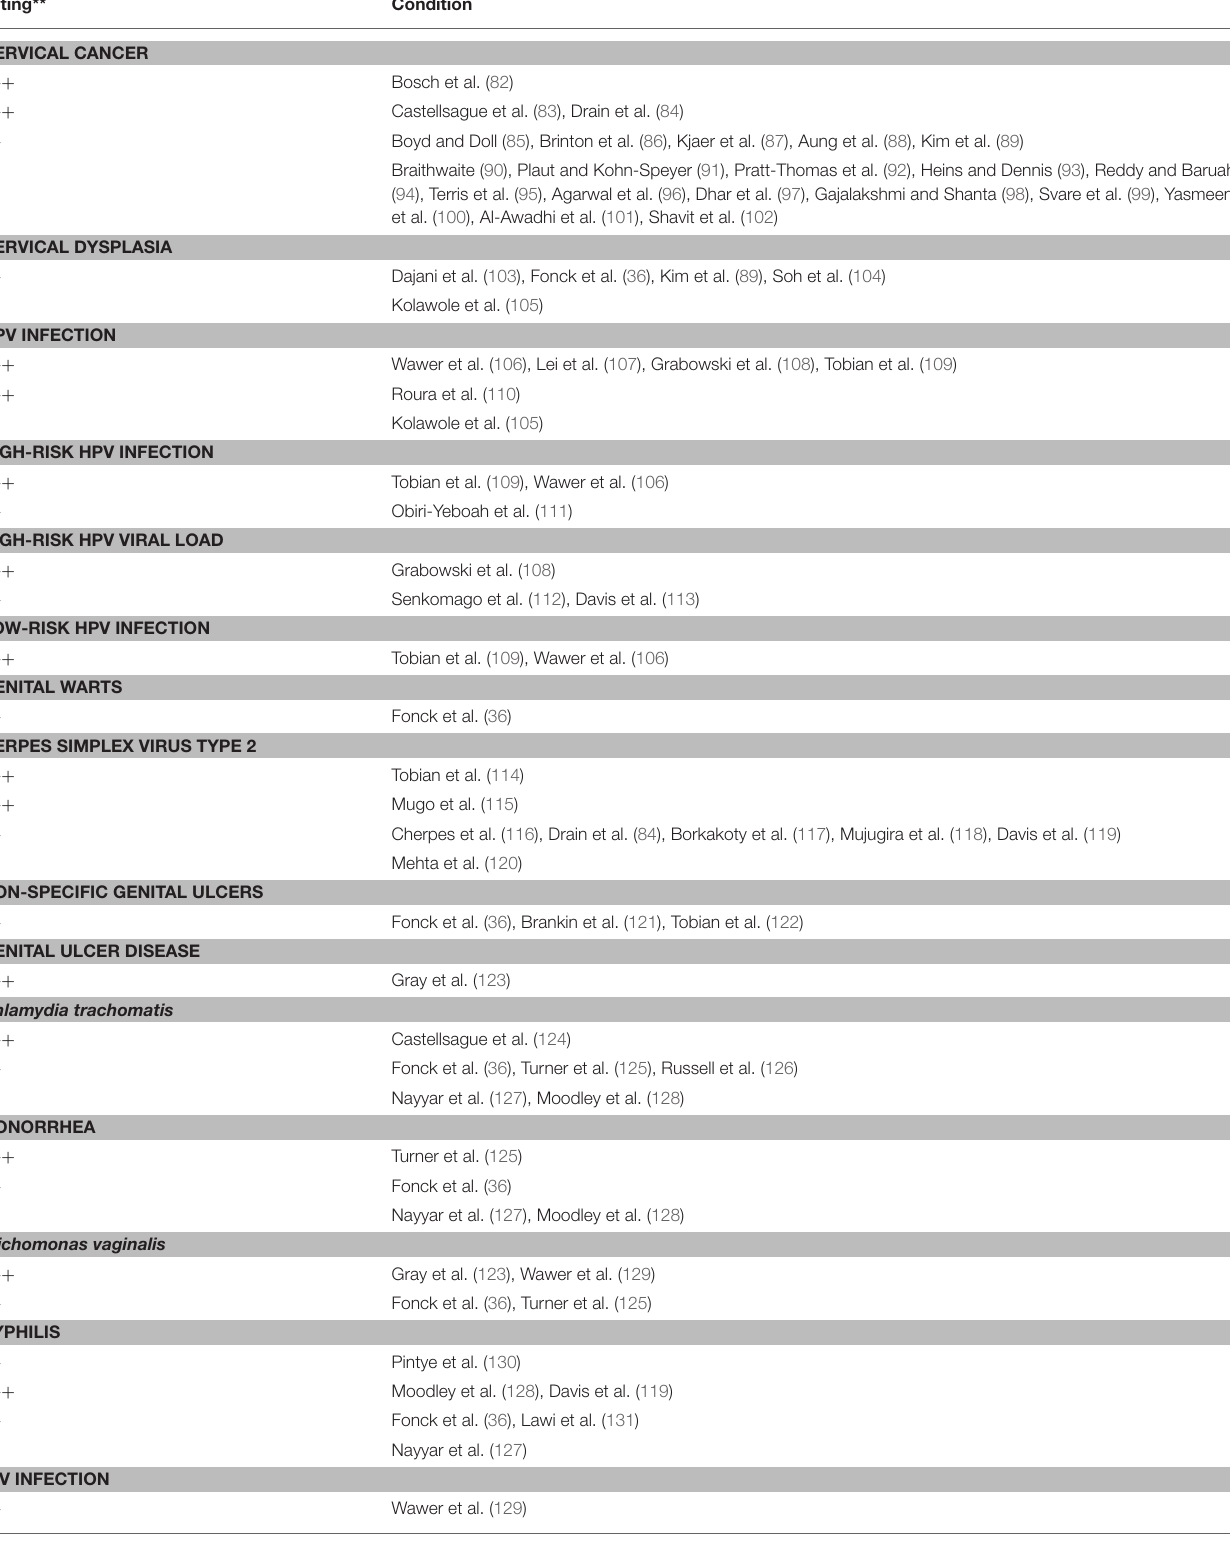
TABLE 1 | Publications on effect of male circumcision on cervical cancer and STIs in female partners,* together with quality rating**. Rating**